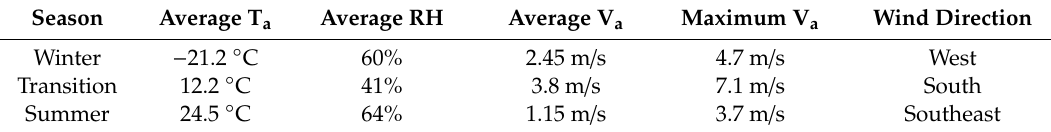
Table 2. The meteorological data of the measured days in di ff erent seasons.